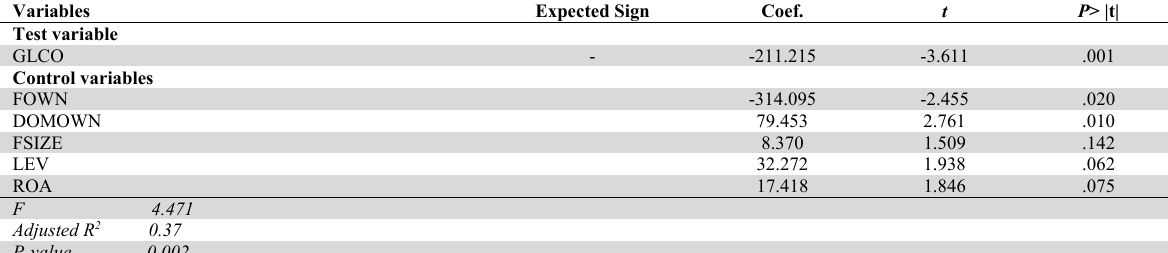
Pooled OLS Analysis Results (Board effectiveness model) Variables Expected Sign Coef. t